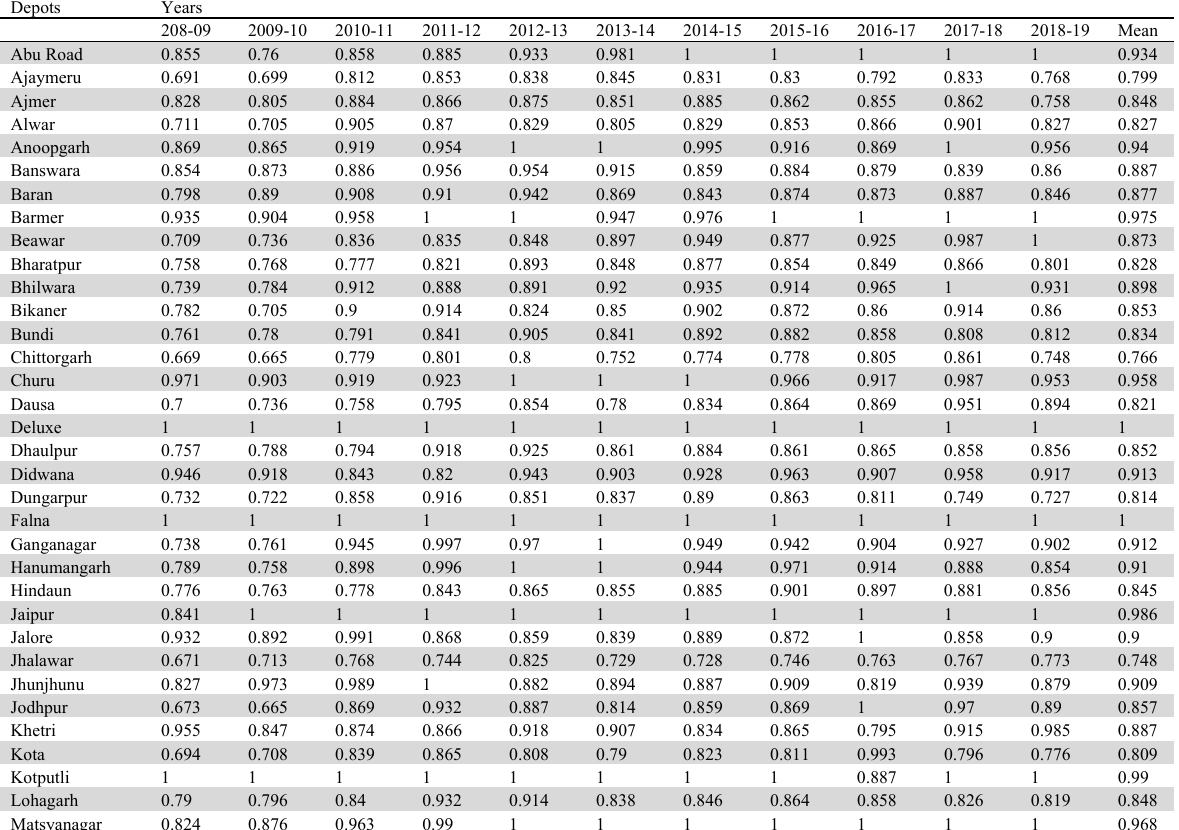
Table 2 Efficiency Values of NSM-VRS